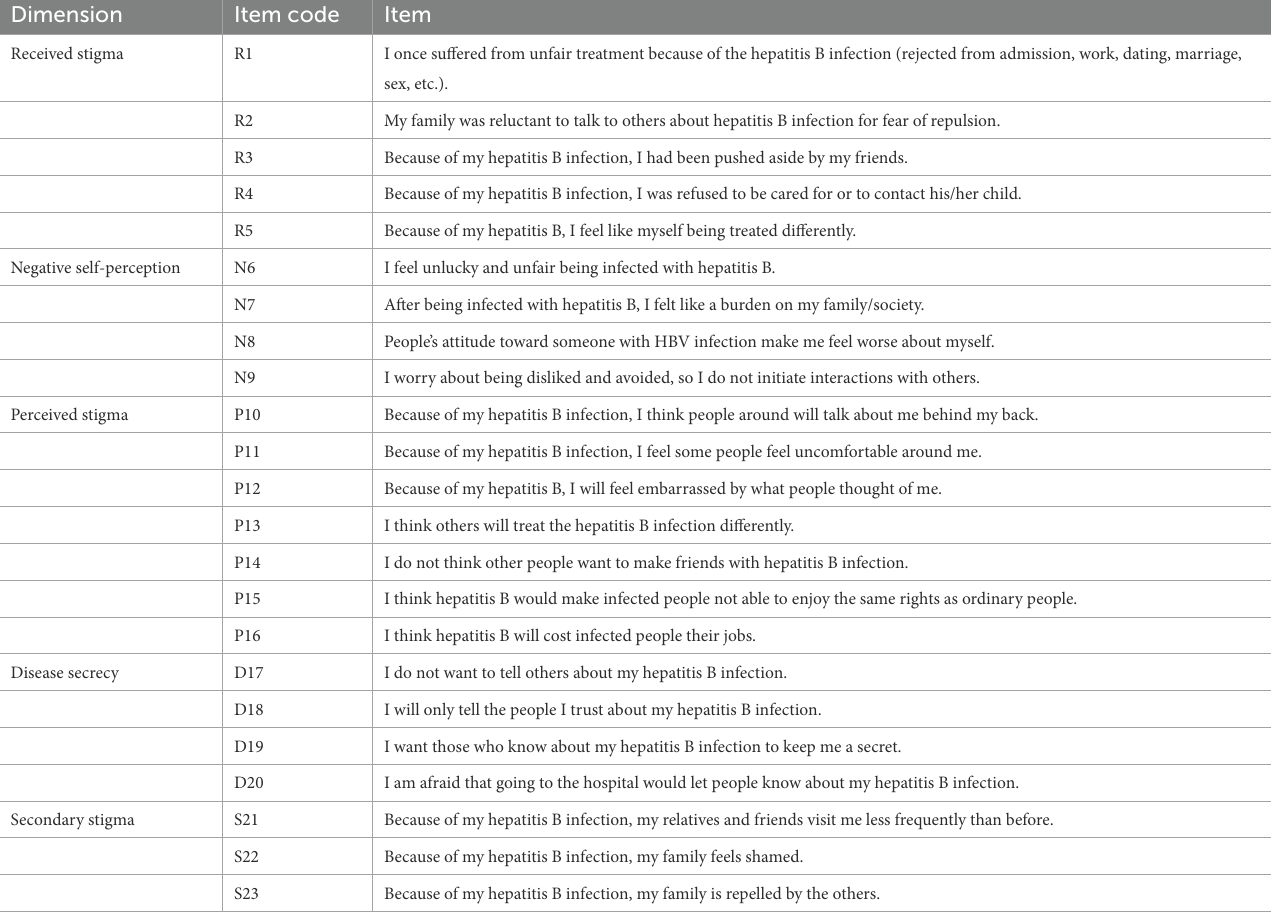
TABLE 1 The dimensions and items of hepatitis B virus infection-related stigma scale. Dimension Item code